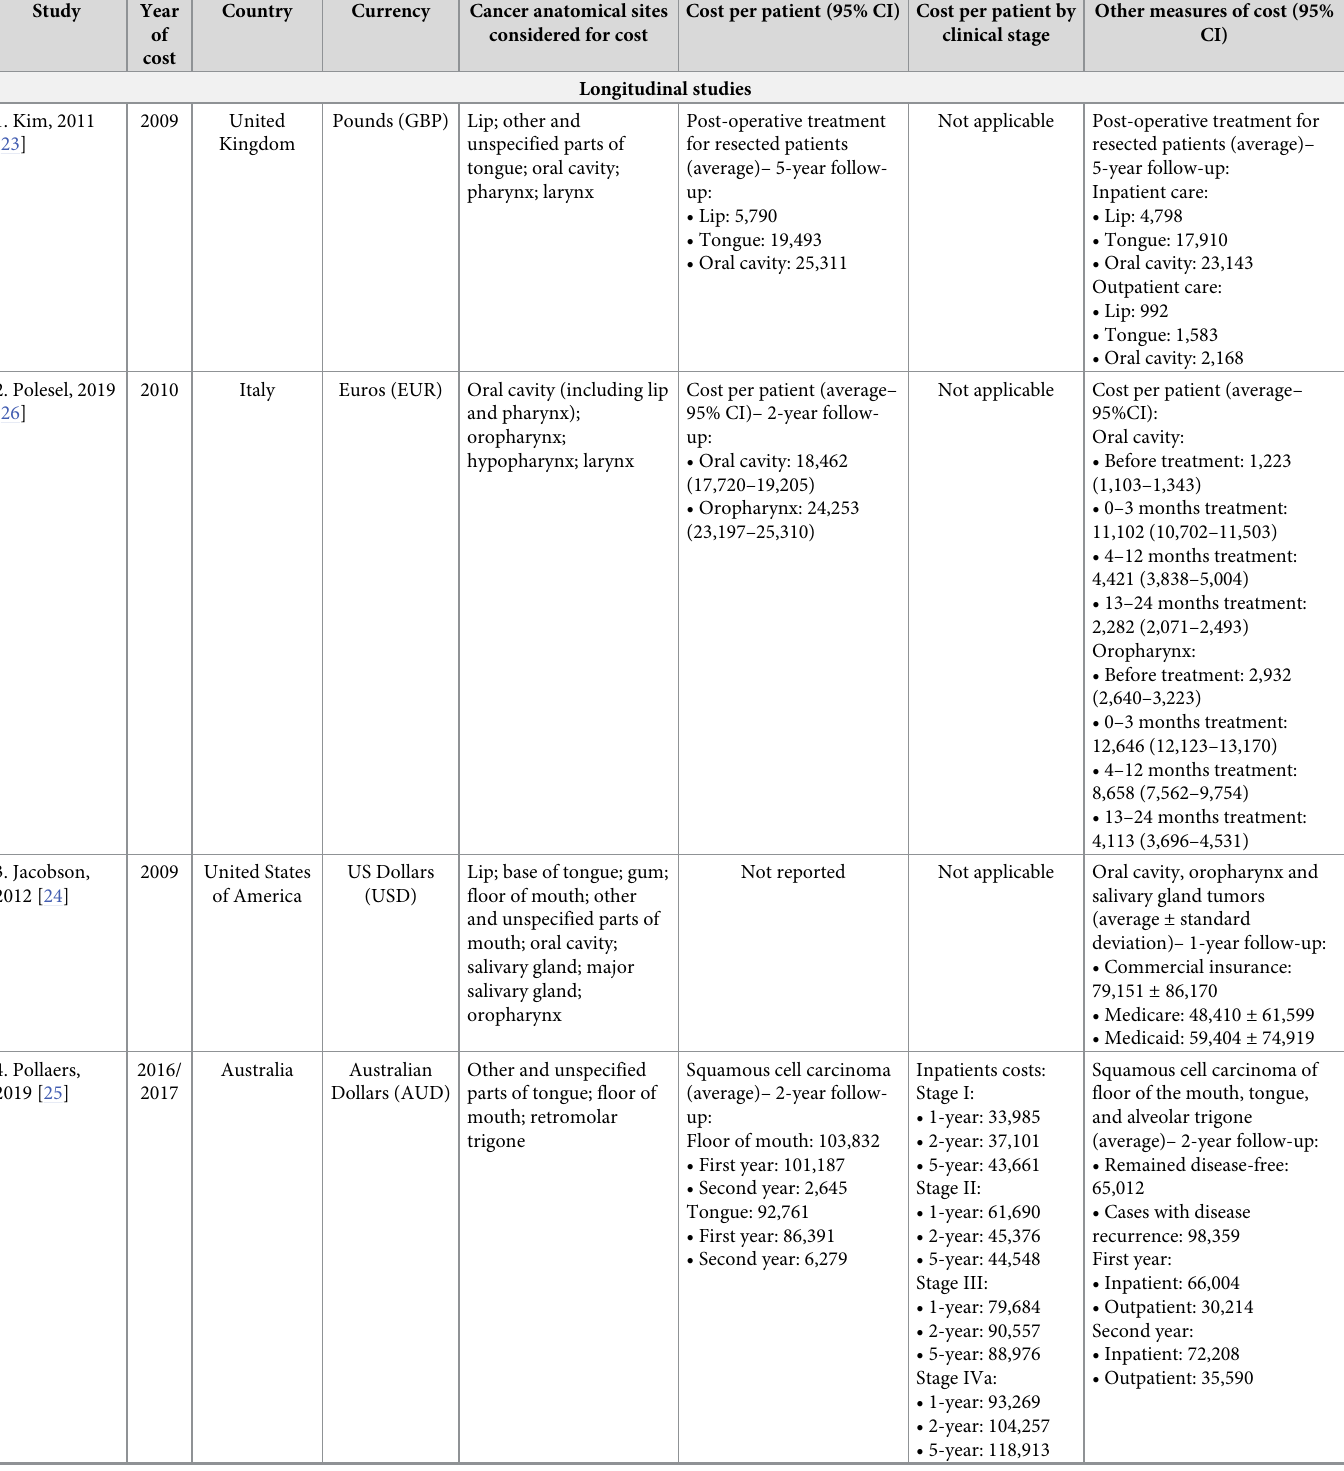
Table 5. Summary of costs estimates of included studies in the systematic